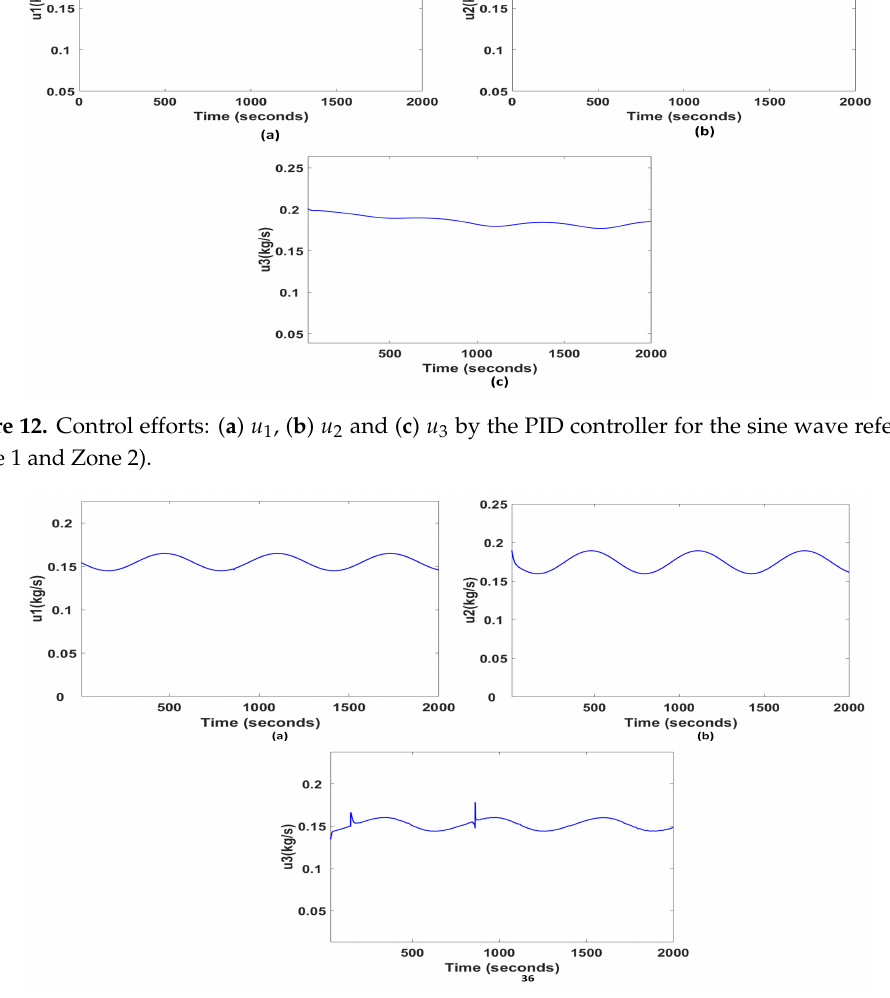
Figure 13. Control efforts: ( a ) u 1 , ( b ) u 2 and ( c ) u 3 by SMC for the sine wave reference (Zone 1 and Zone